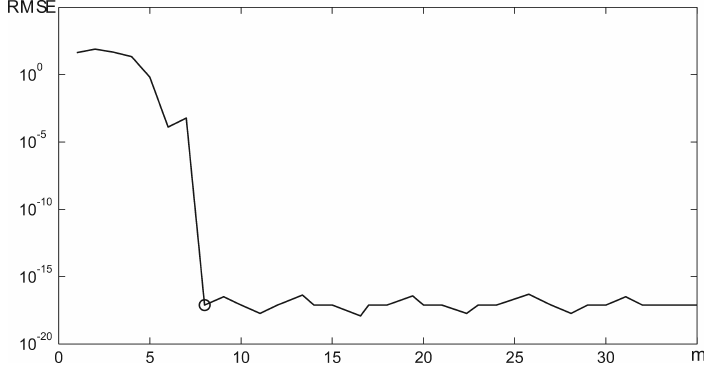
It is clear that RMSE = 0 when m D 8 because the order of f a .x/ is equal to 8. We will illustrate the algorithm of algebraic interpolation for m D 8 in details. The step h is equal to 2